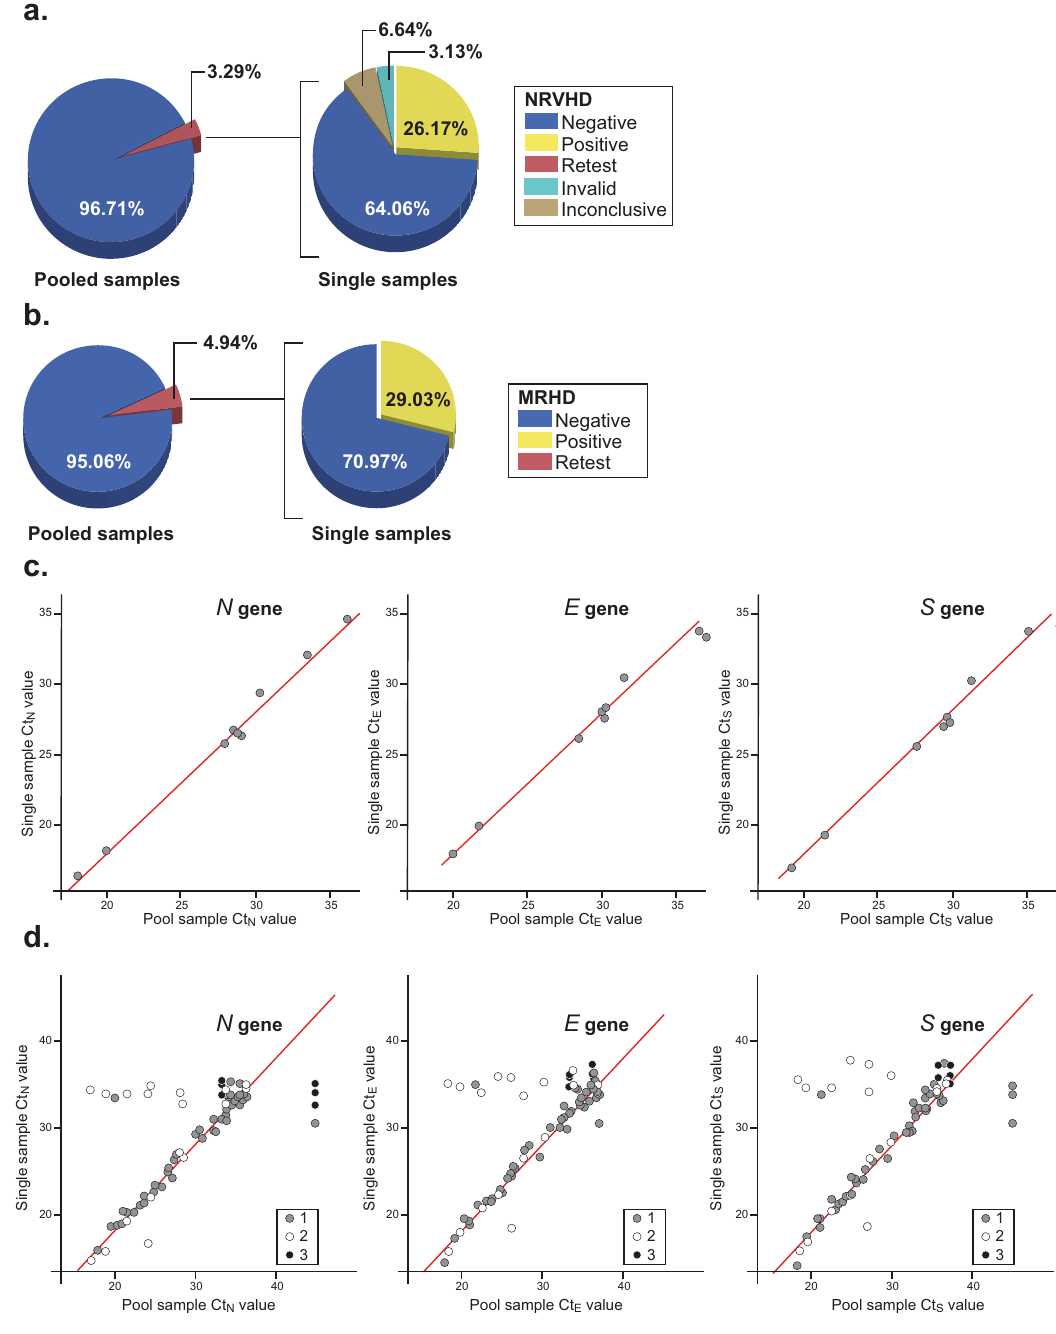
Fig. 3 Pool testing analyses of samples from SWVA. Samples were collected from participants at two locations MRHD (648 participants) and NRVHD (7,792 participants) ( a , b , respectively) and used for pooling studies. Brie fl y, pools of four samples from each district were analyzed by RT-qPCR and deemed negative based on our threshold criteria for Ct values or “ retest ” , if positive or inconclusive. Samples from “ retest pools ” were analyzed as singles. Accordingly, the RNA from each of the original samples in the pool was re-extracted before ampli fi cation and the results grouped as negative, positive, invalid, and inconclusive. c , d Scatter plot showing the association between the Ct value for the pooled sample compared to the Ct value for the positive sample(s) within the pool from the MRHD ( n = 9) ( c ) and NRVHD ( n = 68) ( d ). Points were colored based on the total number of positive samples in the pool of four samples (gray: one positive sample, white: two positive samples, black: three positive samples). Red lines indicate the theoretical Ct value shift (2 Ct units) expected when pooling together one positive sample with three negative